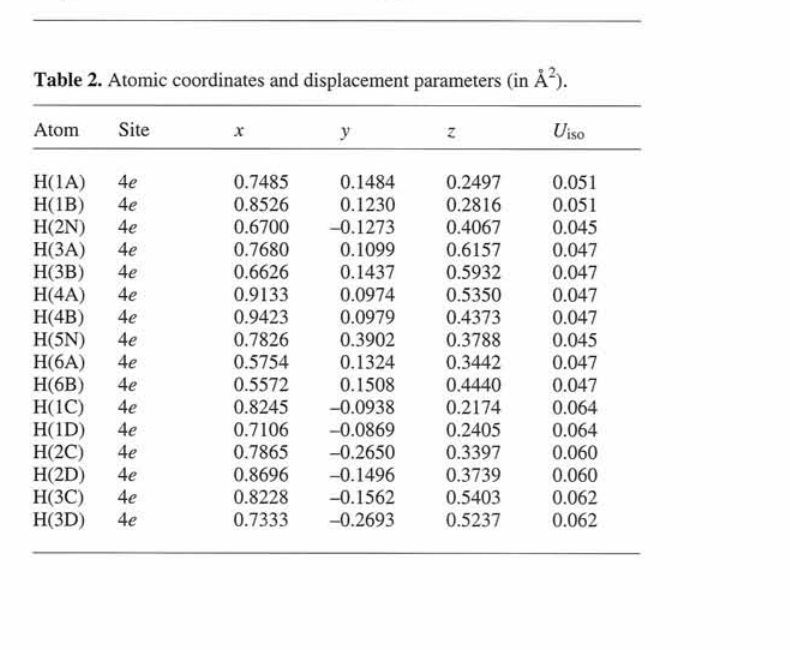
Table 1. Data collection and handling.